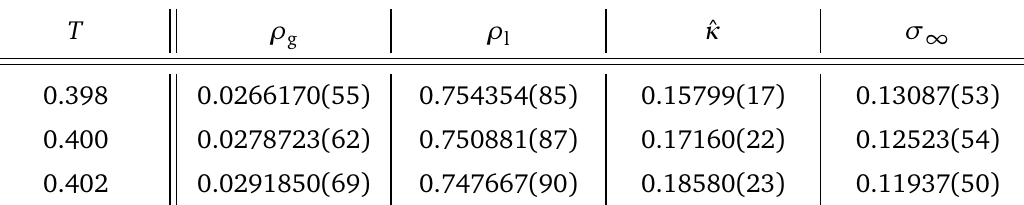
Table 1: Results for the grand canonical reference quantities. Systems of linear size L ≥ 20 were included in the least-square fits (Fig.